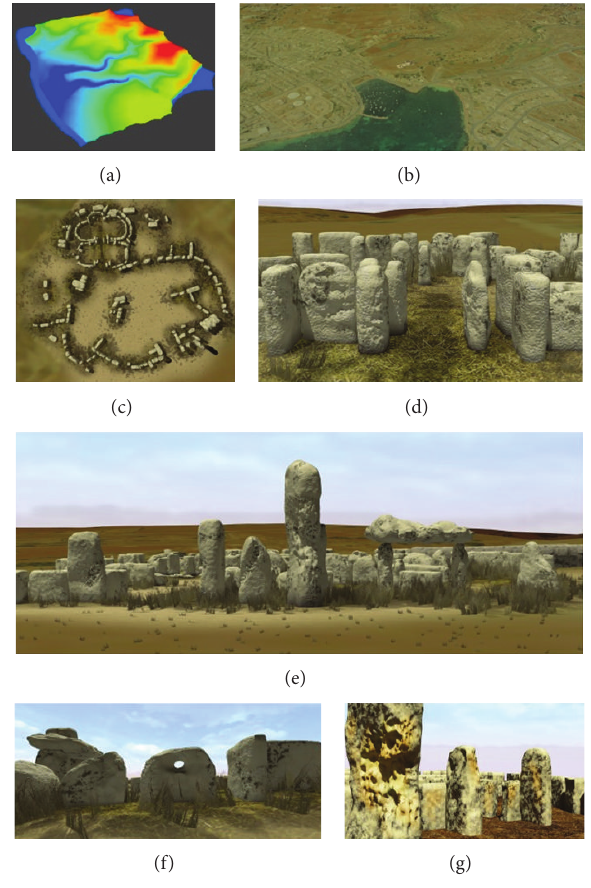
Figure 3: (a) Digital elevation model (DEM); (b) DEM with a superimposed aerial photograph; (c) 3D model of the temple, aerial view; (d) entrance to Apsidal Building; (e) main entrance to the Forecourt; (f) detail of the pierced megalith on the northern outer wall of the Forecourt; (g) detail of the texture used to represent the limestone.